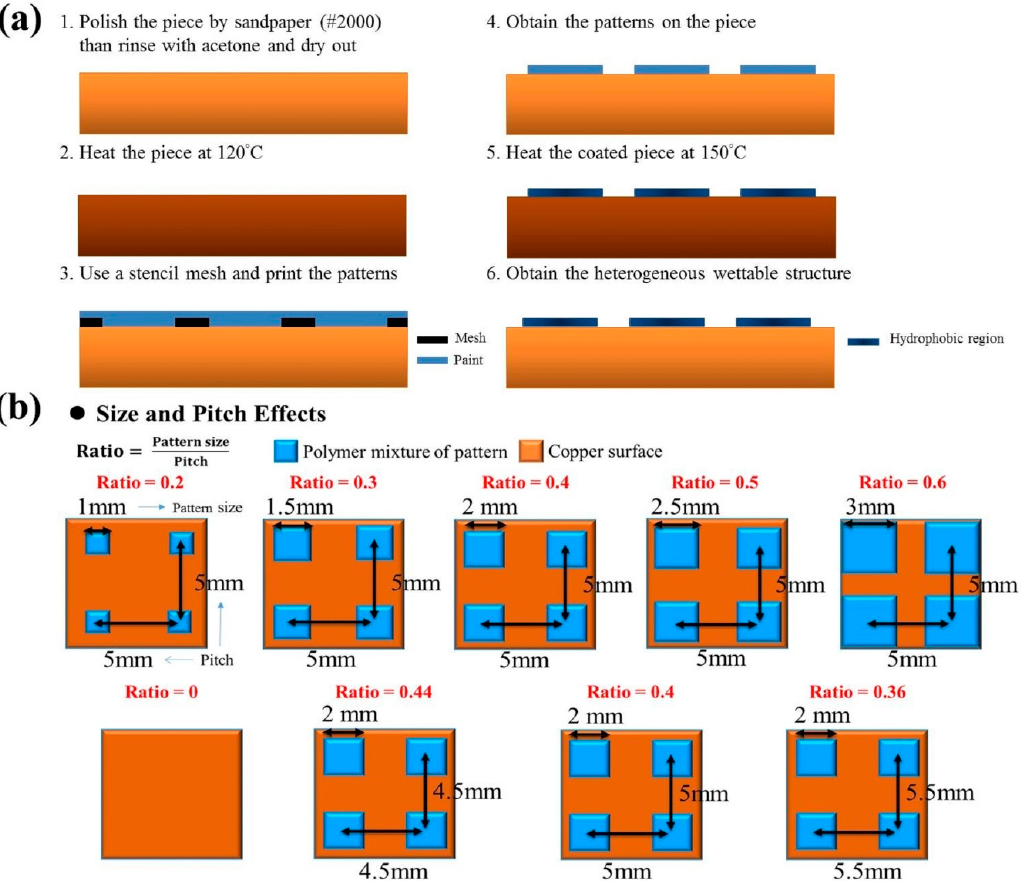
Figure 2. ( a ) Fabrication process for the heterogeneous wettable surface and ( b ) design details of different square patterns.